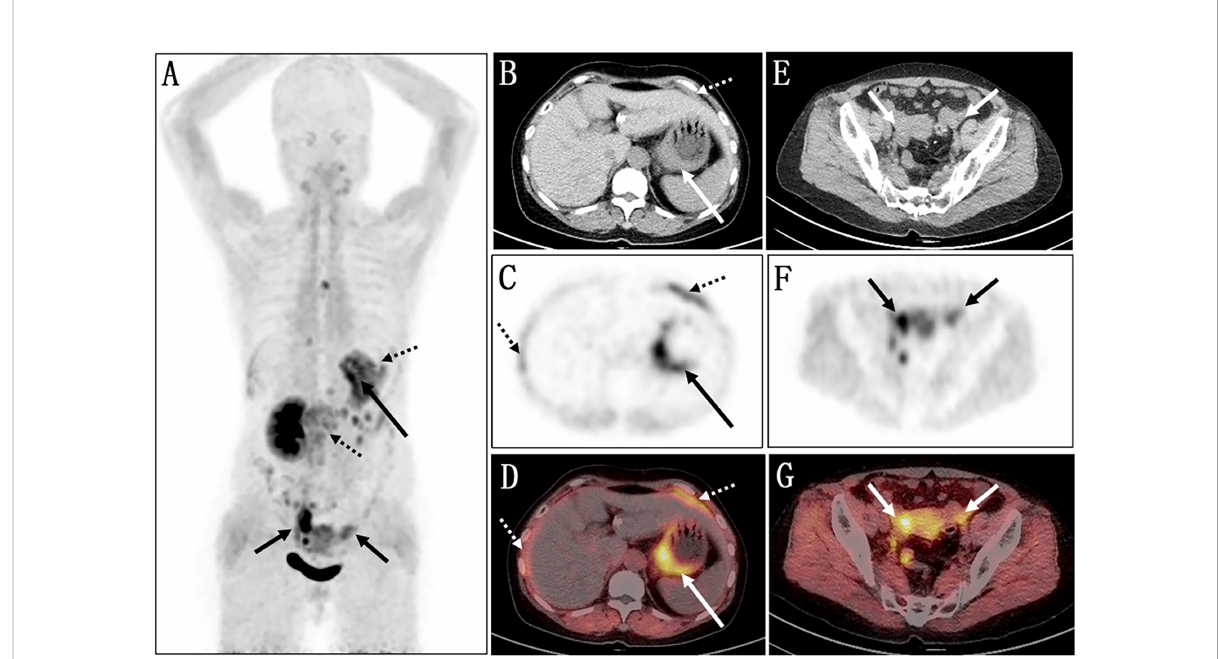
FIGURE 2 Images of 68 Ga-FAPI PET/CT. (A) The MIP image shows several lesions with varying degrees of FAPI uptake. (B – D) Axial views of abdominal cavity demonstrate signi fi cantly elevated FAPI activity in the thickened gastric wall (long arrows; SUV max 9.8). (E – G) The axial images of pelvic cavity reveal abnormal FAPI uptake in the bilateral adnexal areas (short arrows; SUV max of right 11.6, SUV max of left 6.5). (C, D) Furthermore, 68 Ga-FAPI PET/CT showed extensive peritoneal carcinomatosis with FAPI uptake (dotted arrows; SUV